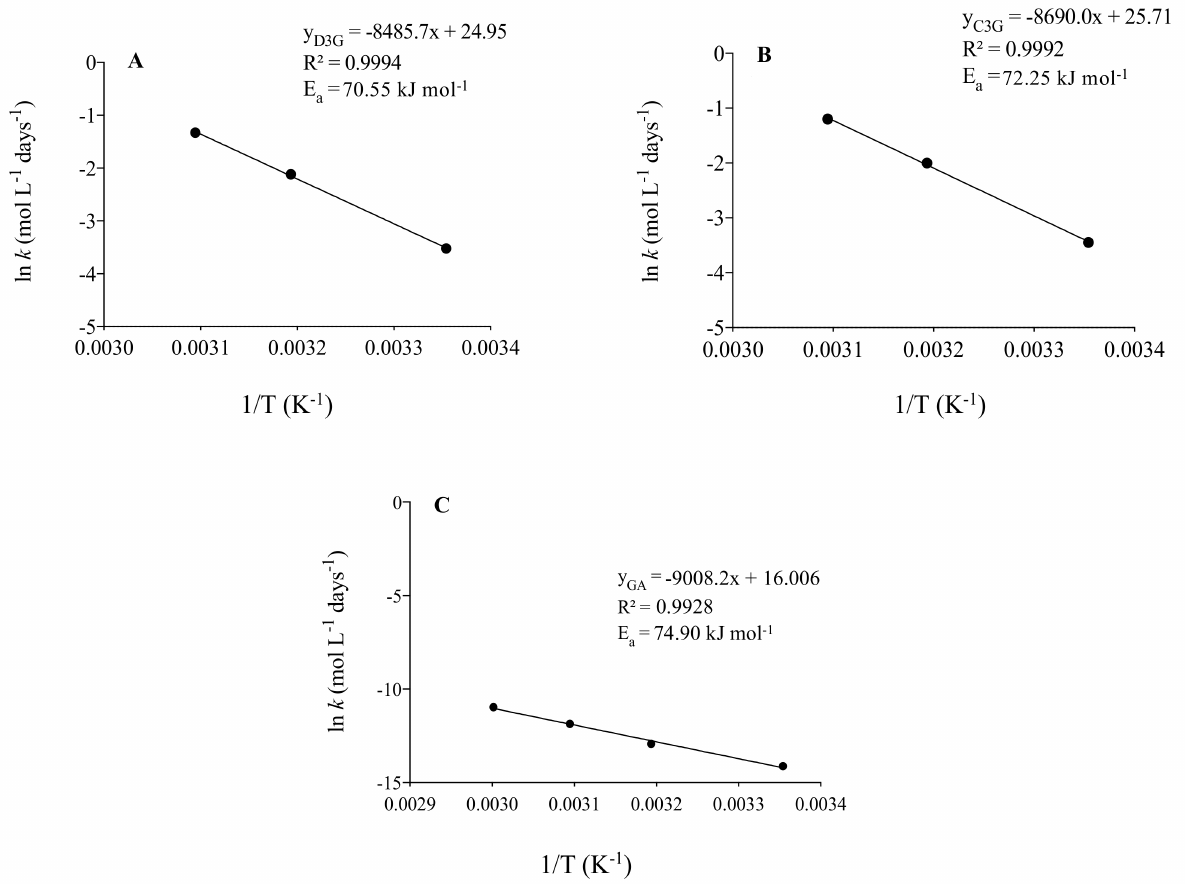
Figure 4. Arrhenius plots of delphinidin-3- O -glucoside (D3G) ( A ) and cyanidin-3- O -glucoside (C3G) ( B ) degradation and of gallic acid ( C )